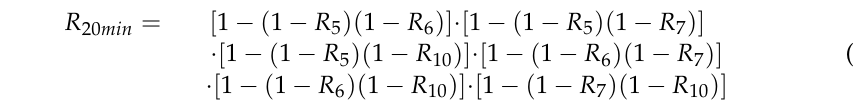
Table 3. The results of reliability analysis of the two degrees of freedom structure in the following minutes of fire duration.